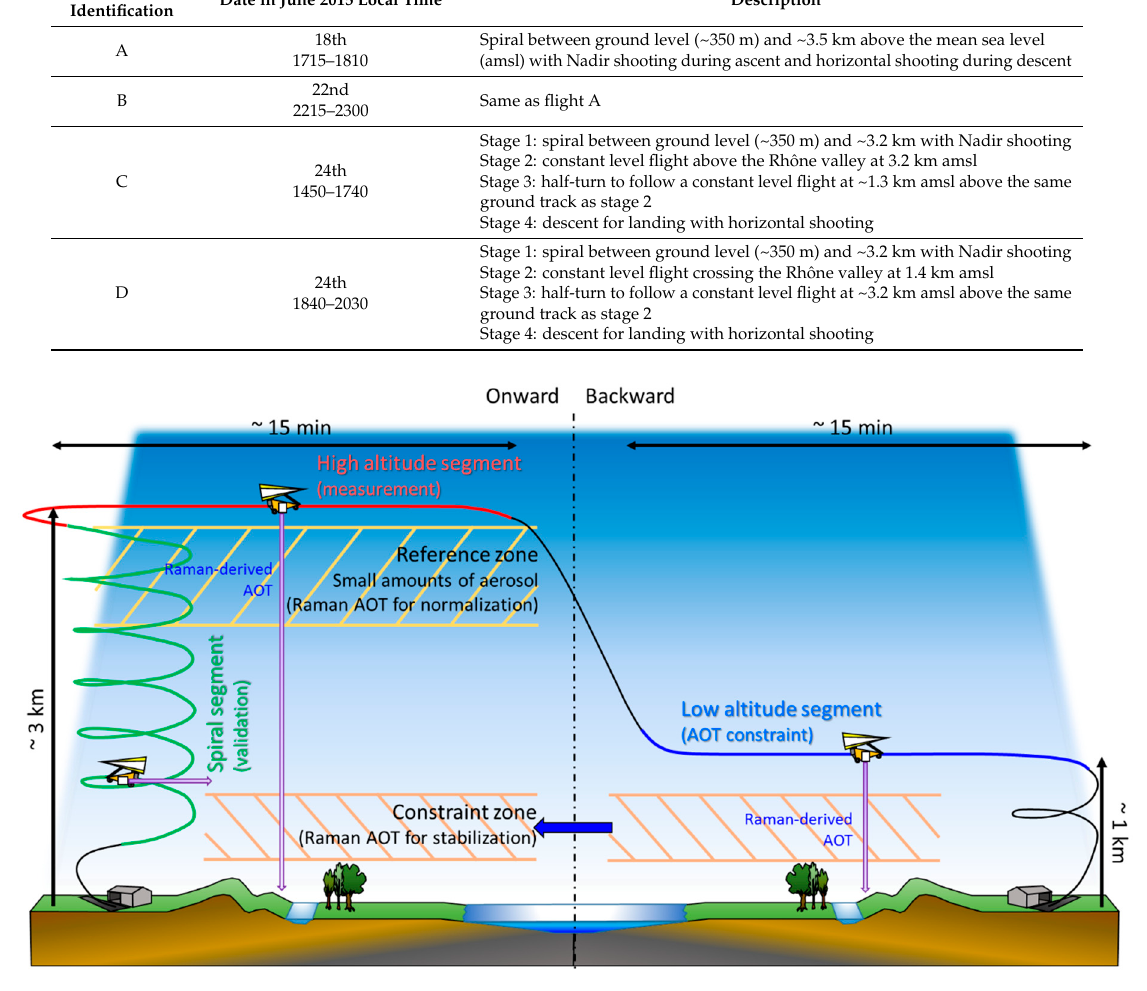
Figure 1. Schematic representation of the ideal flight plan to implement the inversion method described in Section 2.2.